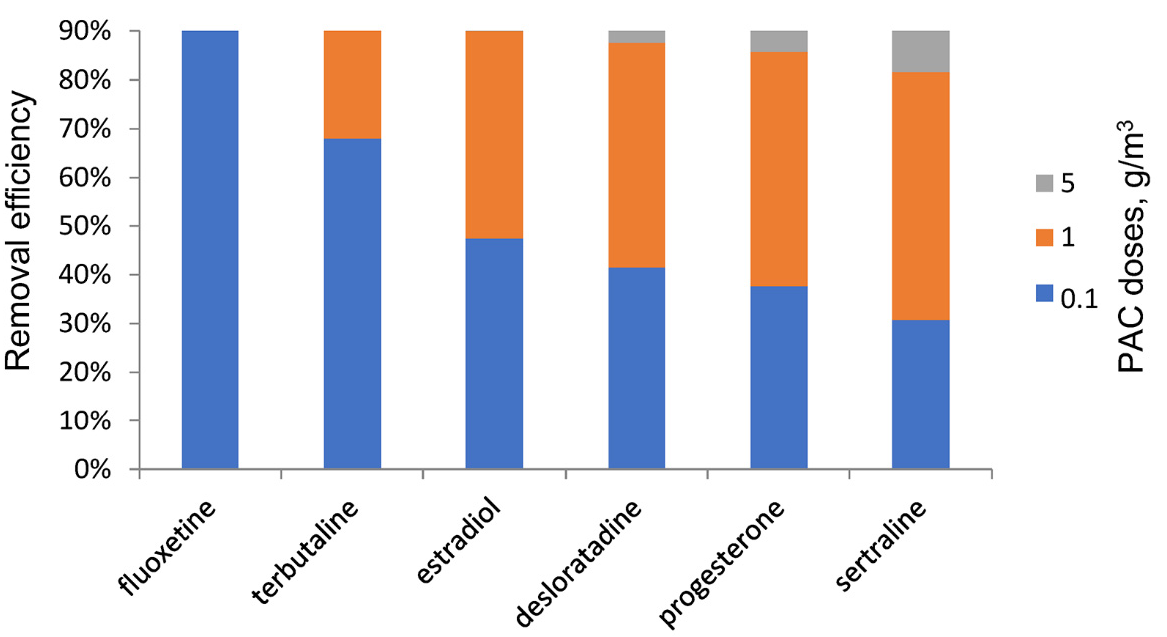
Figure 2. Amount of PAC needed in order to reach 90% reduction of the pharmaceuticals present in the range of 10–100 ng/L in wastewater effluents .